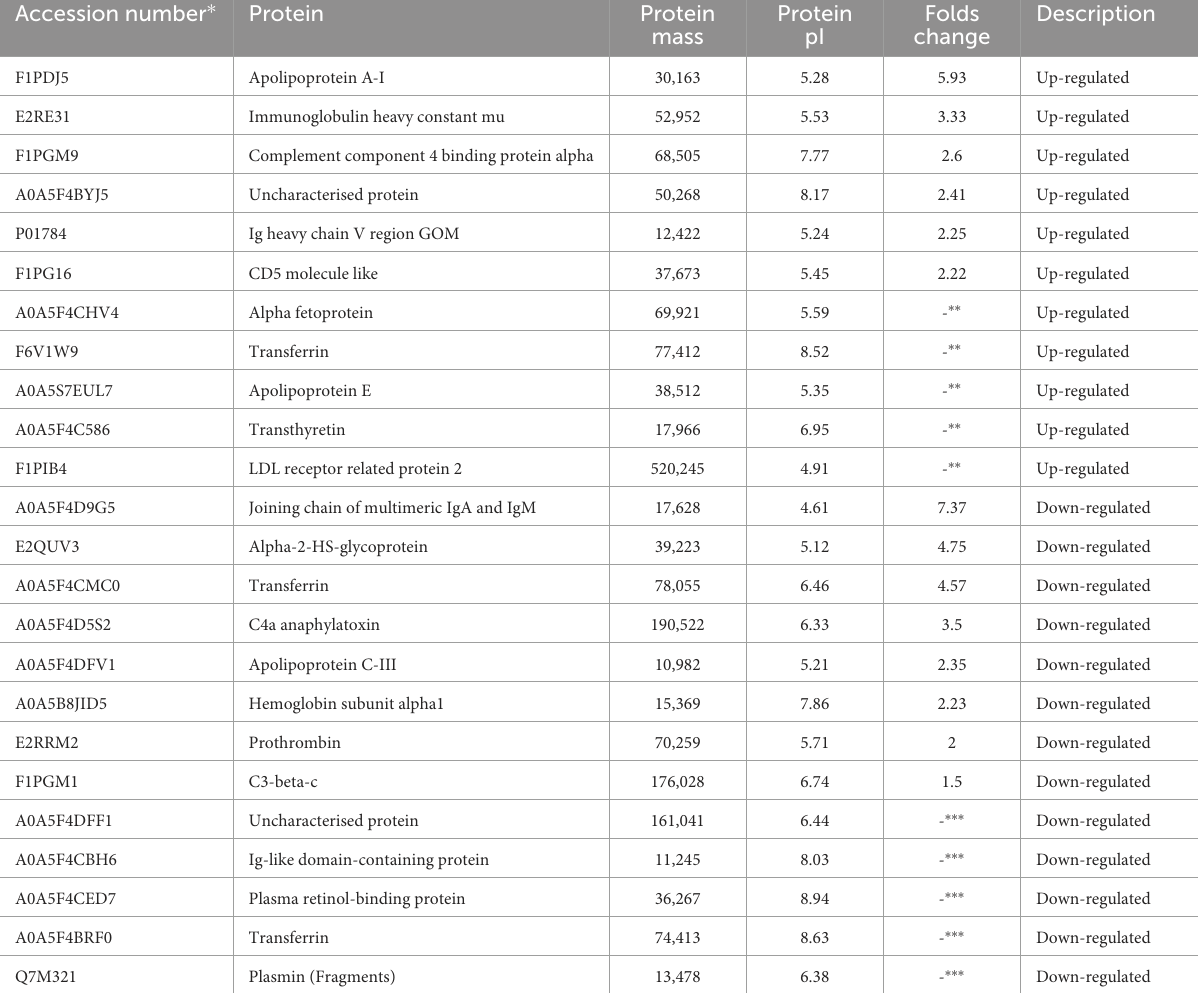
TABLE 2 Comparison of the protein fold change between the DM day 180 and DM day 0